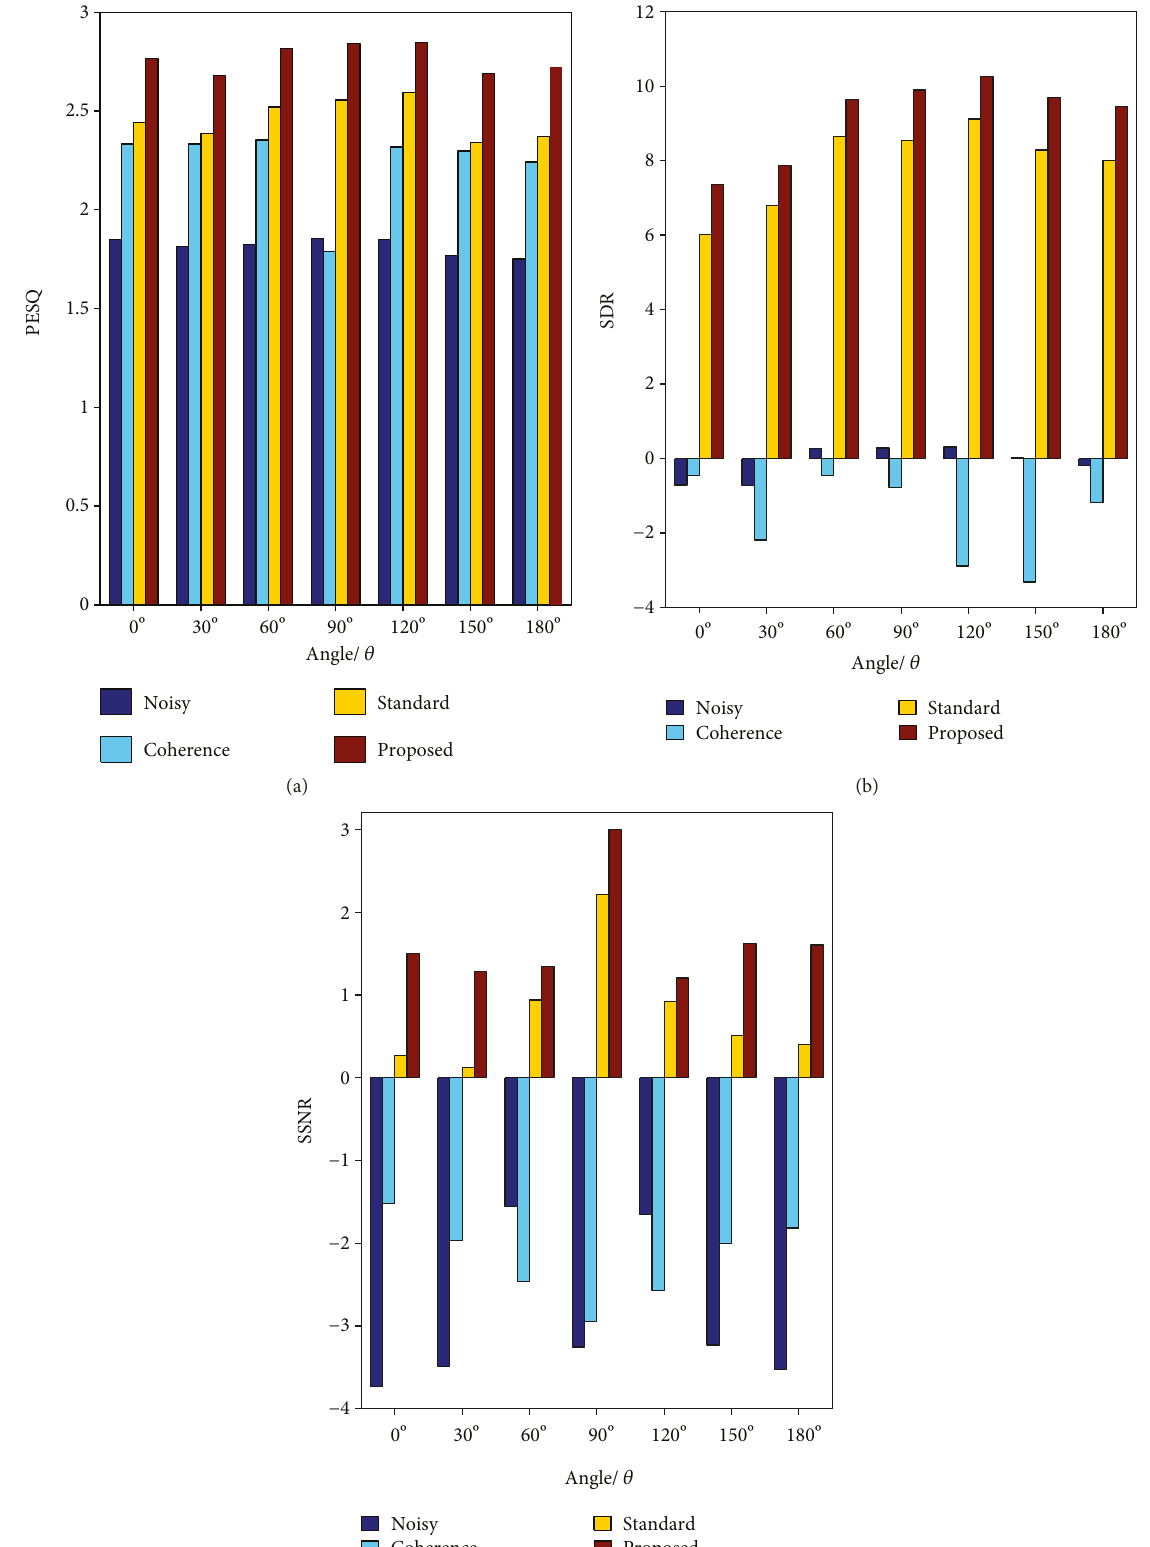
Figure 2: PESQ, SDR, and SSNR values of the enhanced speech from Factory1 noise at 0dB input